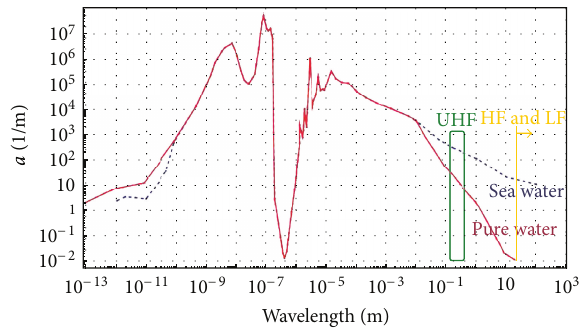
F 14: Water absorption spectrum.